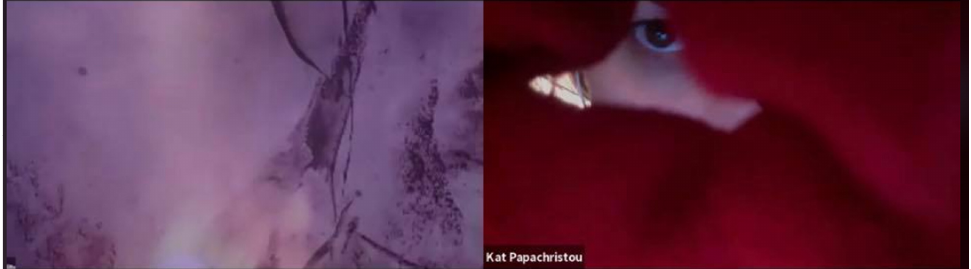
Figure 12. Noor Inayat Khan, directed by Elli Papakonstantinou, Telemachus, in Aède of the Ocean and Land: A Play in Seven Acts . 2020. Screenshot from the Zoom Live Music-Cinema Event. © The Inayatiyya.